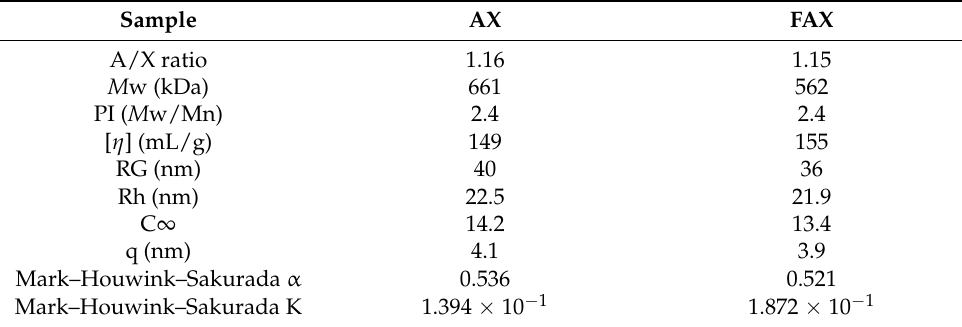
Table 2. Macromolecular characteristics of AX and FAX.